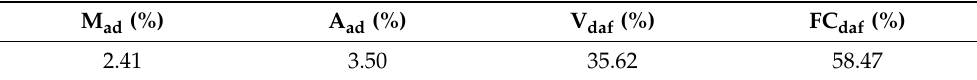
Table 1. The proximate analysis of coal sample.